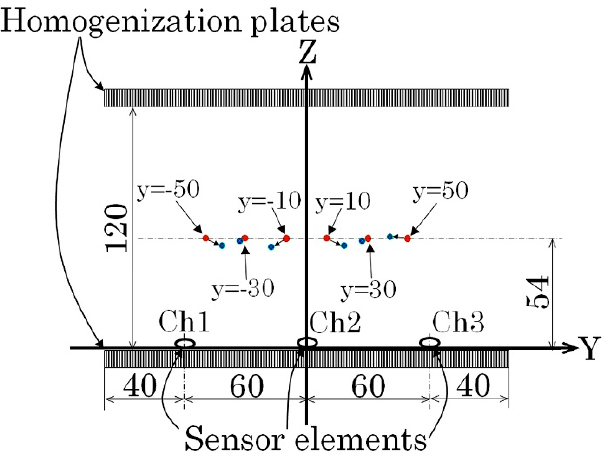
Figure 23. Estimated results for the second experiment (Red: actual position, Blue: estimation). Table 1. Results of position estimation (second experiment). Actual Position